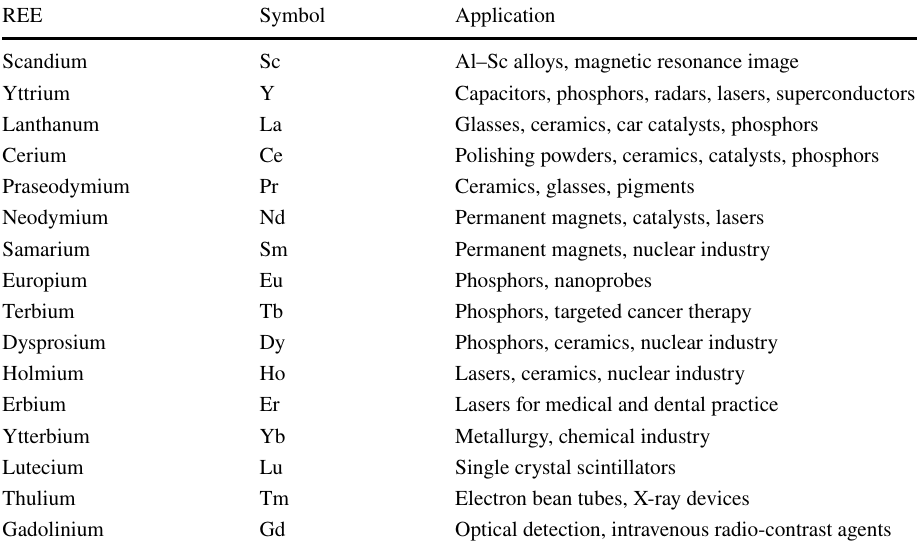
Table 1 Main industrial applications of rare-earth elements (Charalampides et al. 2015; Giese